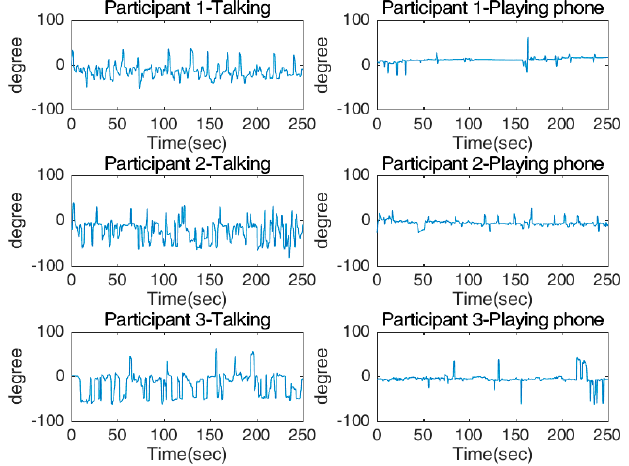
Figure 14. Measured shaking angles for two tasks: talking ( left column) and playing phone ( right column).